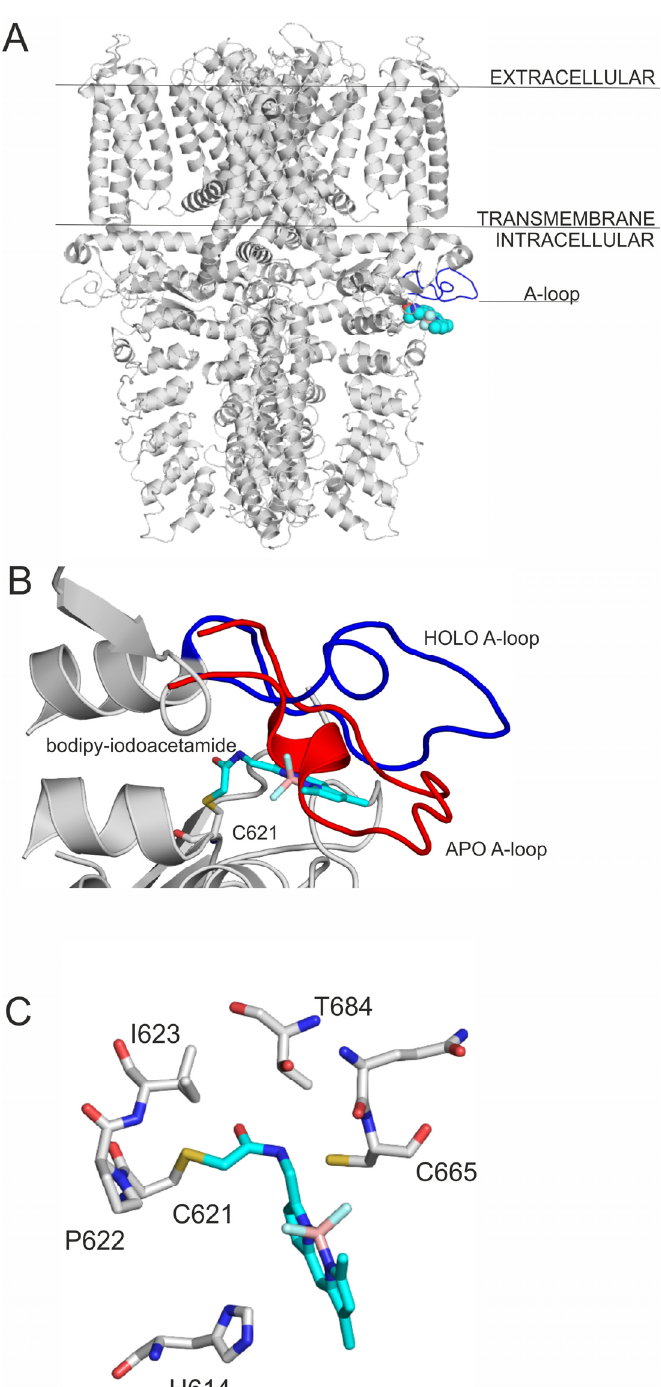
Figure 2. ( A ) The TRPA1 ion channel shown as grey cartoon representation, the agonist binding site is shown by the binding of bodipy-iodoacetamide (PDB: 6v9v) as teal spheres. The A-loop is highlighted with blue; ( B ) the movement of the A-loop during ligand binding. The figure was prepared with the superposition of 6v9w on 6pqo. The blue loop is A-loop in the holo, open form, and the red is A-loop in the apo, closed form. The rest of the binding site is shown with grey cartoon. bodipy-iodoacetamide is shown in teal sticks, and C621 in all atom representation grey sticks. ( C ) The close-up of the binding of bodipy-iodoacetamide to the agonist binding site of TRPA1, interacting amino acids are shown as grey thick lines in all atom representation, bodipy-iodoacetamide is shown as teal all atom representation sticks.